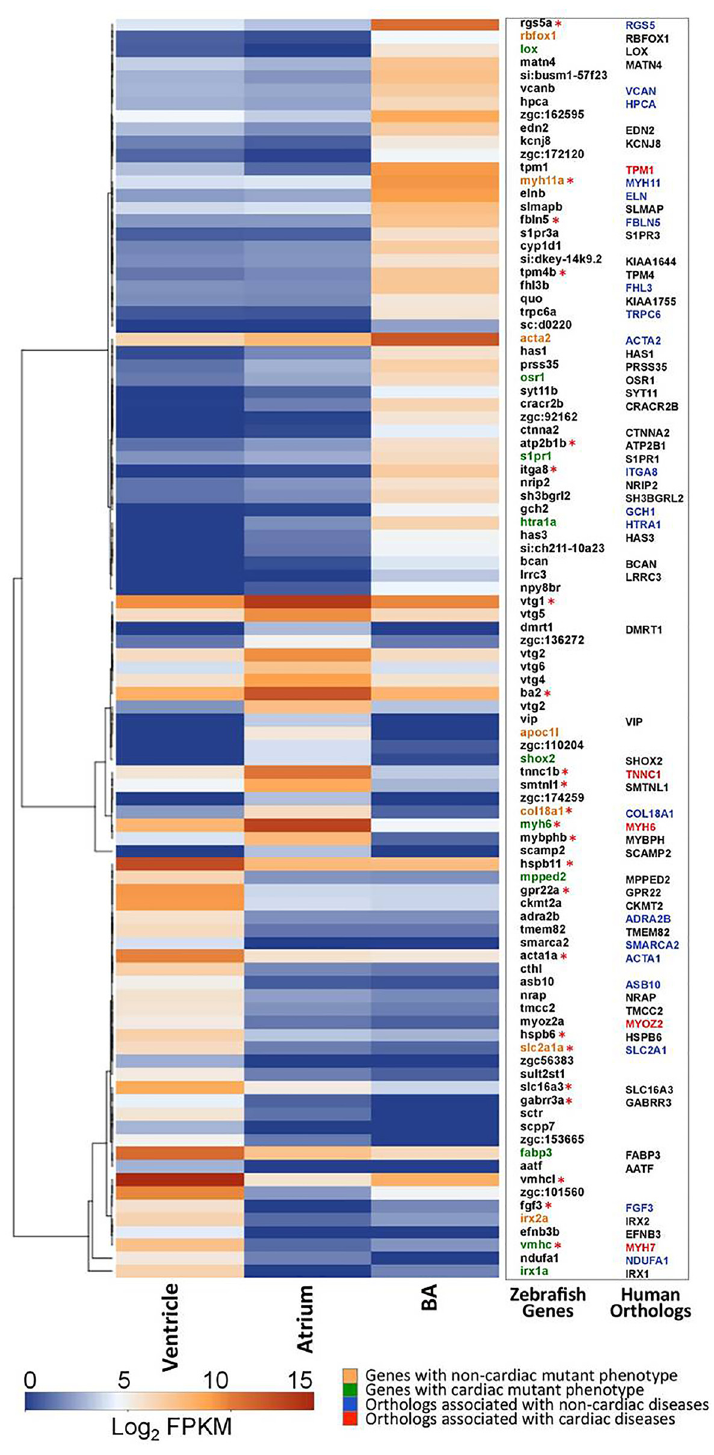
Fig 2. Differential expression of genes in the three cardiac chambers. The heat map represents expression profile of 96 cardiac chamber-restricted genes. The first column in the adjoining table lists the corresponding zebrafish gene names which are colour coded to highlight those with mutant phenotypes. Genes marked with green colour signify those which have been identified with heart related mutant phenotypes. The second column lists the human orthologs known for these genes. Genes marked